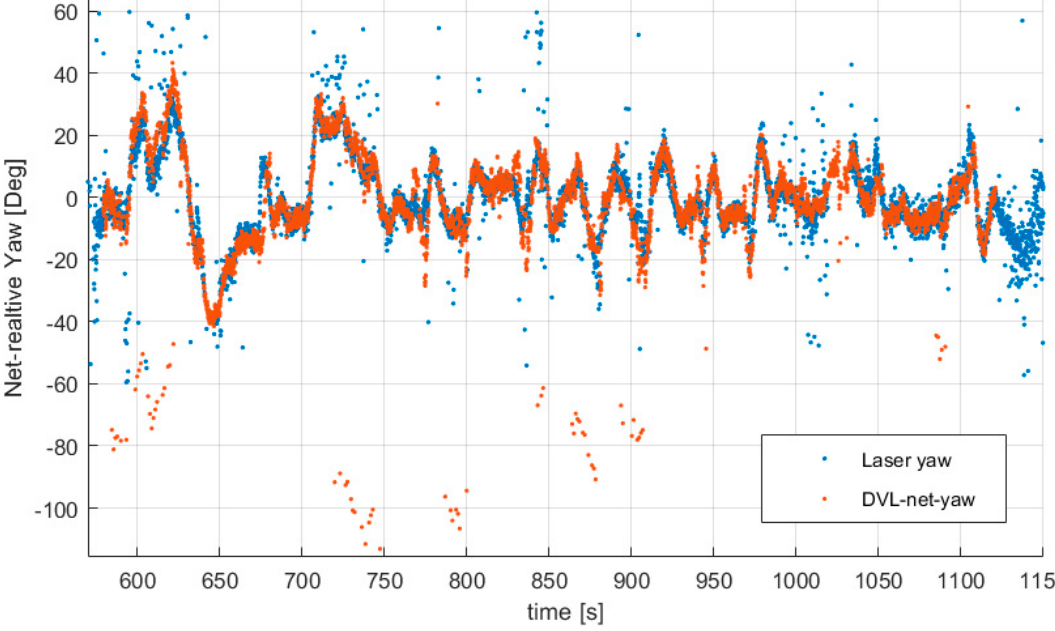
Figure 11. The DVL net-relative yaw compared with the laser triangulation measurement.